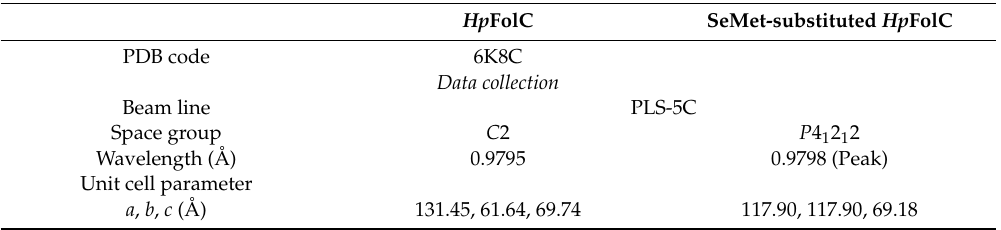
Table 1. Statistics for data collection and model